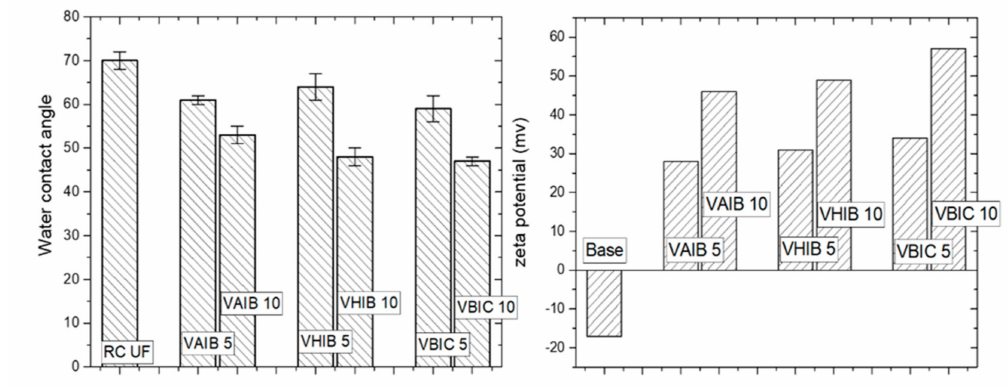
Figure 4. Water contact angles and the zeta potential for the responsive membranes.